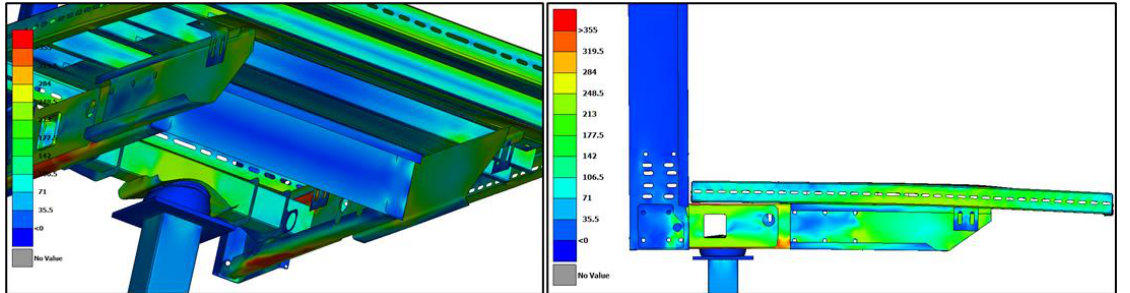
Figure 14. Von-Mises stress distribution on new-design elevator chassis for 6 mm settlement plate thickness. Plastic deformation of the settlement plate touching suspending beam. Deformation of flexible cantilever components.